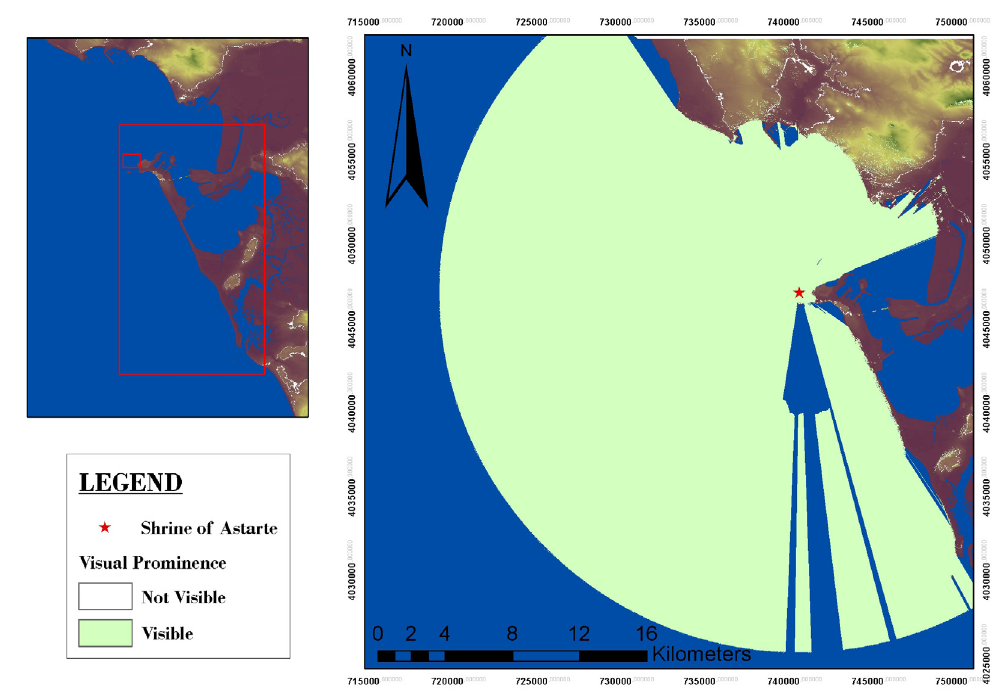
Figure 5. Analysed theoretical viewshed for the shrine of Astarte /Punta del Nao. Projection of this viewshed extended towards the mainland.